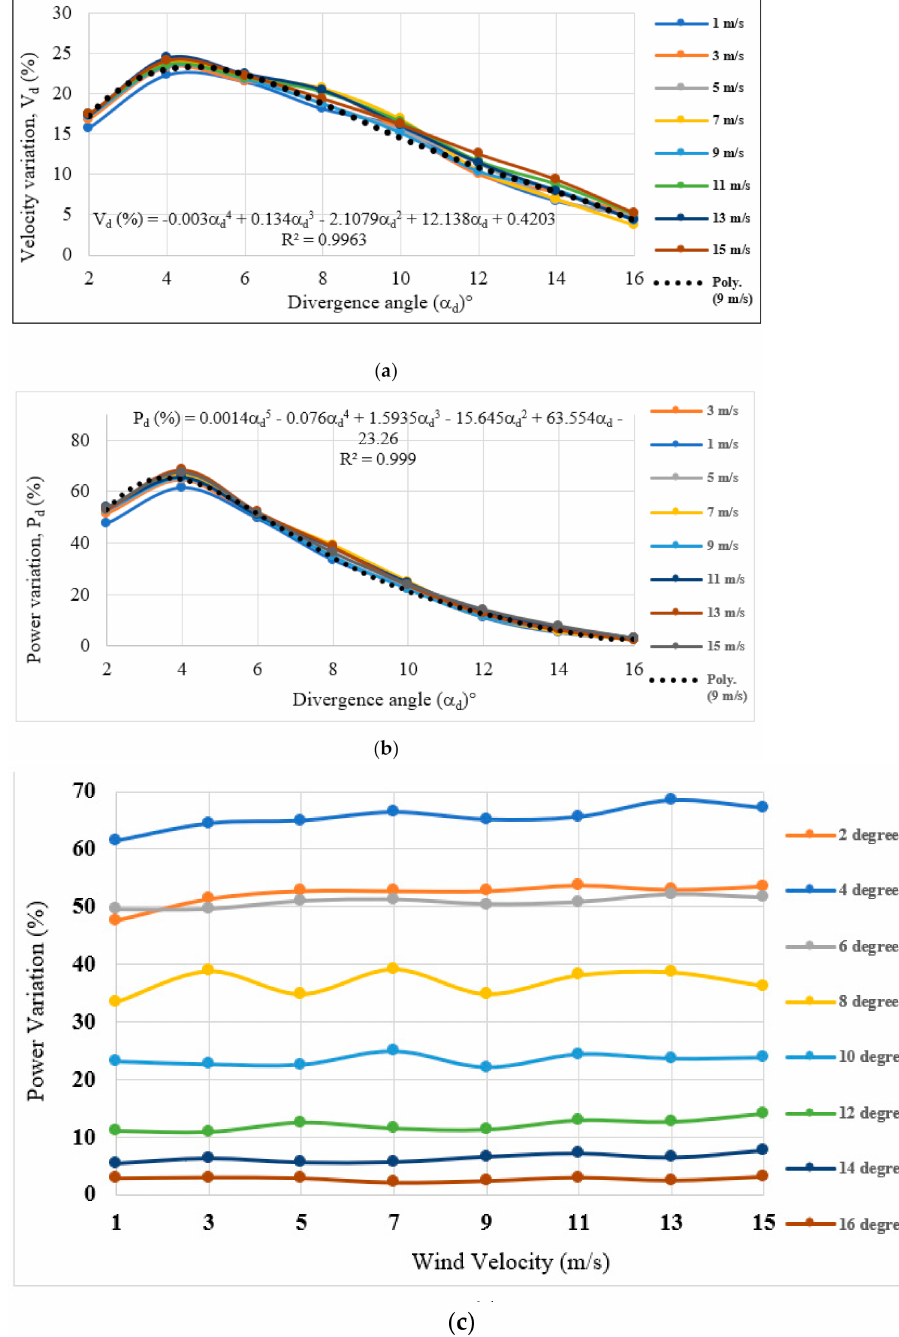
Figure 10. Effect of α d on: ( a ) velocity variation, V d %; ( b ) power variation, P d %, for a diffuser; ( c ) power variation (%) with respect to wind velocity for different divergence